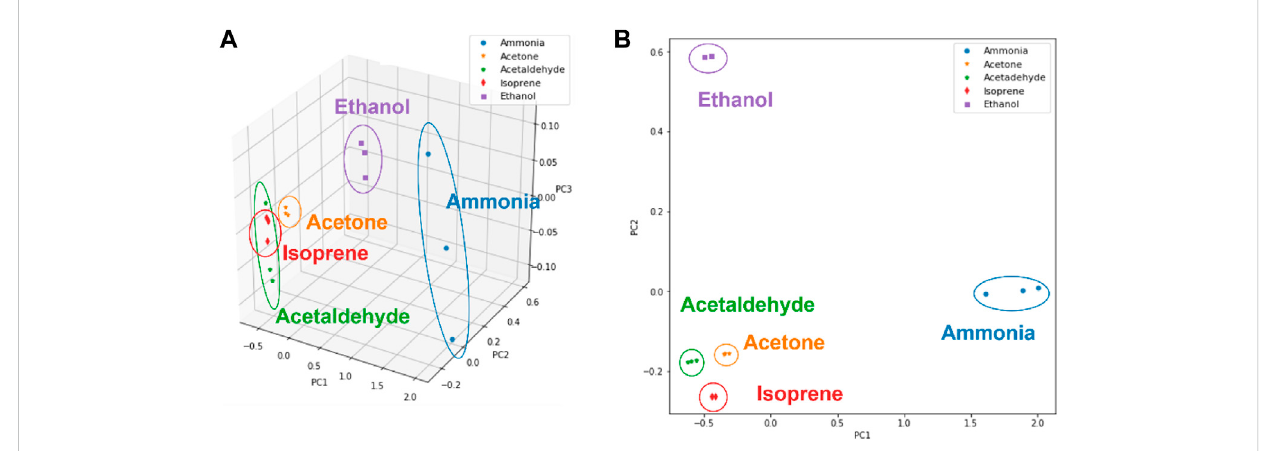
FIGURE 6 Gases recognization for fi ve kinds of VOCs (ammonia, ethanol isoprene, acetaldehyde, isoprene and acetone) by PCA algorithm. (A) 3D PCA result. (B) 2D PCA result.